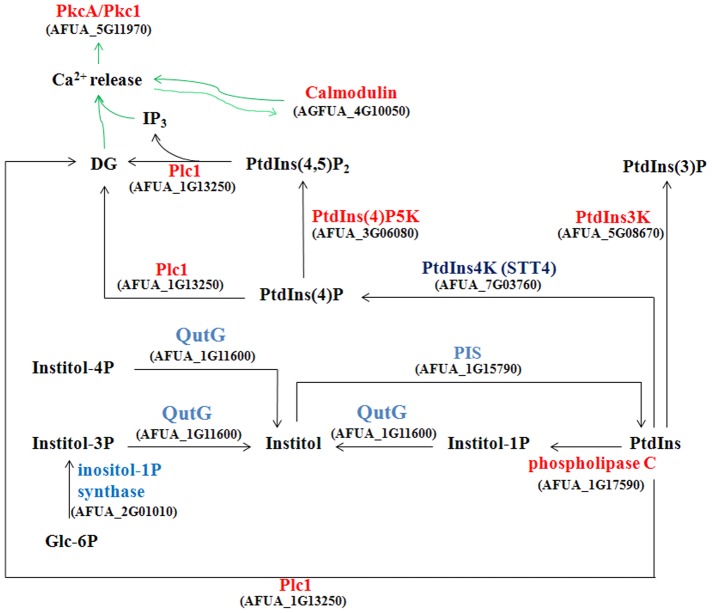
Phosphatidylinositol (PtdIns) metabolism and signaling in the mutant.As revealed by transcriptome data, PtdIns synthesis was suppressed in the mutant, including QutG (inositol monophosphatase), myo-inositol-1-phosphate synthase, and PIS (CDP-diacylglycerol-inositol 3-phosphatidyltransferase). On the other hand, the genes encoding PtdIns4(P)5K (PtdIns-4-phosphate 5-kinase), PtdIns3K (PtdIns 3-kinase), Plc1 (PtdIns-4,5-bisphosphate phosphodiesterase) and calmodulin were induced at least 1.5-fold. PtdIns3K catalyzes the conversion of PtdIns into PtdIns(3)P (PtdIns-3-phosphate), whereas PtdIns4(P)5K catalyzes the conversion of PtdIns(4)P (PtdIns-4-phosphate) into PtdIns(4,5)P2 (PtdIns-4,5-biphosphate). PtdIns, PtdIns(4)P and PtdIns(4,5)P2 all can be hydrolyzed into diacylglycerol (DG) by Plc1. IP3 diffuses in the cytoplasm and binds to its receptor (IP3R), which is an intracellular ligand-gated Ca2+ release channel localized primarily in the endoplasmic reticulum (ER). Then Ca2+ in the ER would be released into the cytoplasm. The Ca2+ can activate PKC (protein kinase C) and calmodulin which regulates the Ca2+ release channel in return. DG also can induce the Ca2+ release and activates the PKC PkcA/Pkc1. Red, induced protein; blue, suppressed protein. Green arrow indicates activation.